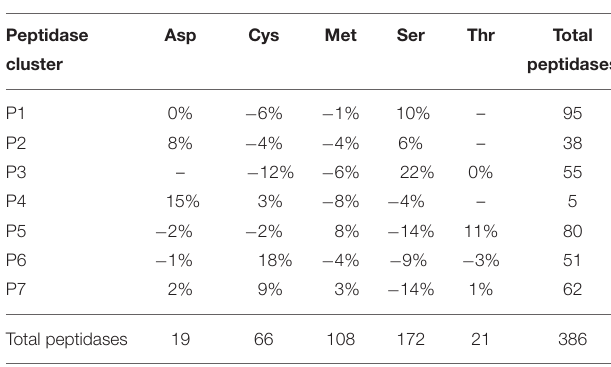
TABLE 3 | Peptidase nucleophile type is enriched according to gene expression profile.